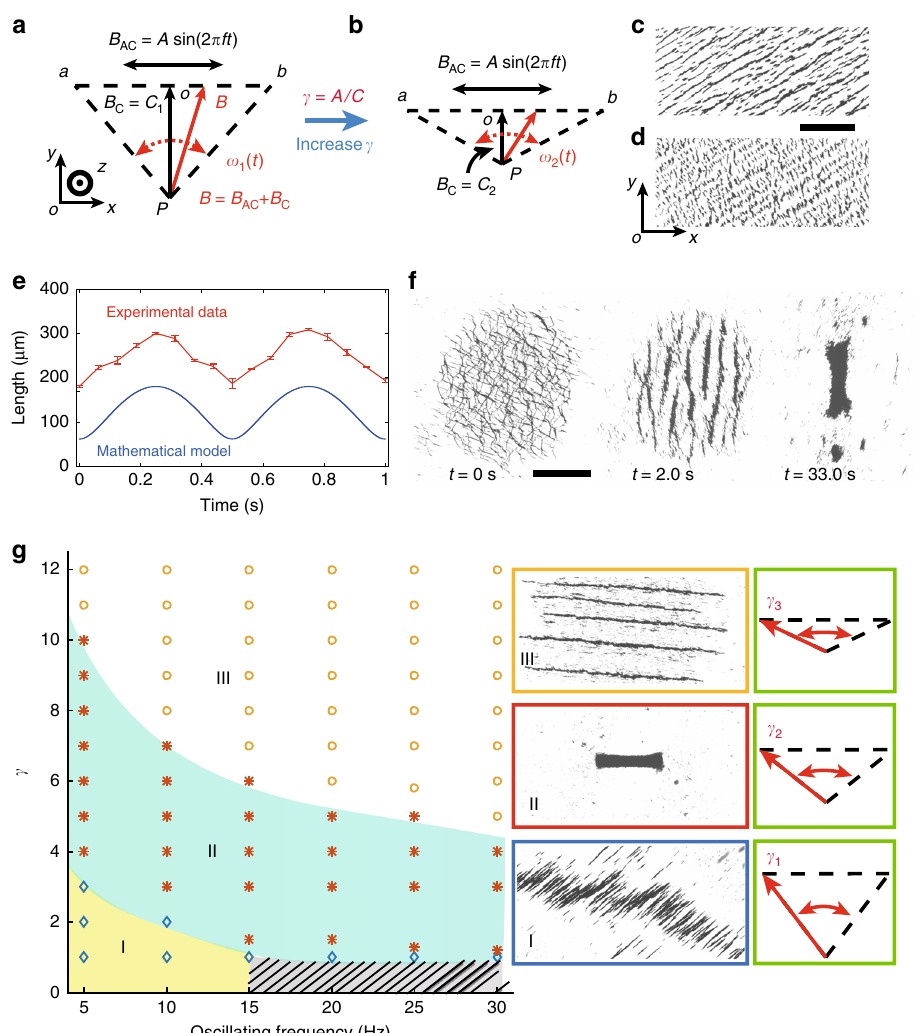
Fig. 1 Actuation of ribbon-like magnetic microswarm using oscillating magnetic fi elds. a A schematic depiction illustrates the applied oscillating magnetic fi eld. The red arrow shows the magnetic fi eld, which is the superposition of B B fi eld is represented by ω ( t ). The C and AC . The angular velocity of the amplitude ratio is γ = A / C , and A is 10 mT in this paper. b A schematic depiction illustrates the oscillating magnetic fi eld when the amplitude ratio is increased. c The particle chain formed when the fi eld points a or b , in which case the fi eld strength is the largest. The scale bar is 400 μ m. d The particle chain formed when the fi eld points O , in which case the fi eld strength is the weakest. In c and d the applied oscillating frequency is 3 Hz. e The relationship between the length of the particle chains and time, actuated by the oscillating magnetic fi eld. Each data point represents the average of 3 experiments. The error bar indicates the standard deviation (s.d.). f The generation process of an RPNS (Supplementary Movie 1). The scale bar is 800 μ m. g The phase diagram showing the swarm patterns actuated by different input magnetic fi elds. The oscillating fi elds that trigger different swarm patterns are schematically presented in the green rectangles. In the grey shadowed region, no regular patterns can be